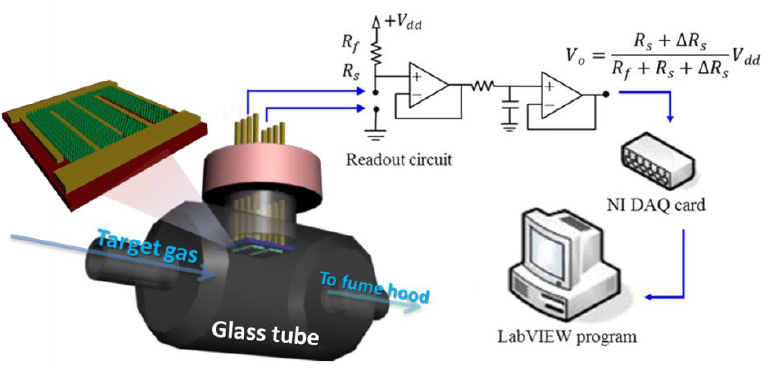
Figure 2. Schematic diagram of gas sensing measurement systems.